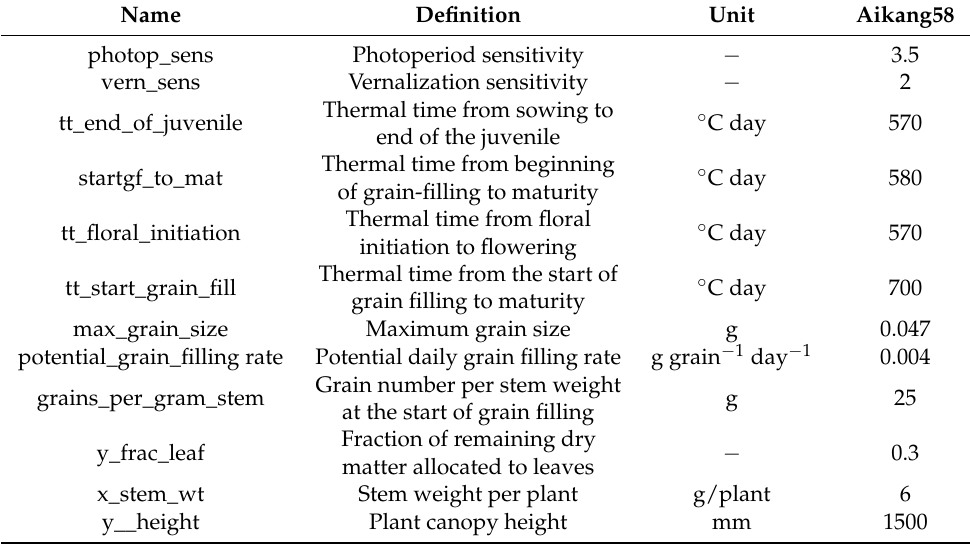
Table 6. Genetic parameters for winter wheat cultivar “Aikang58” in this